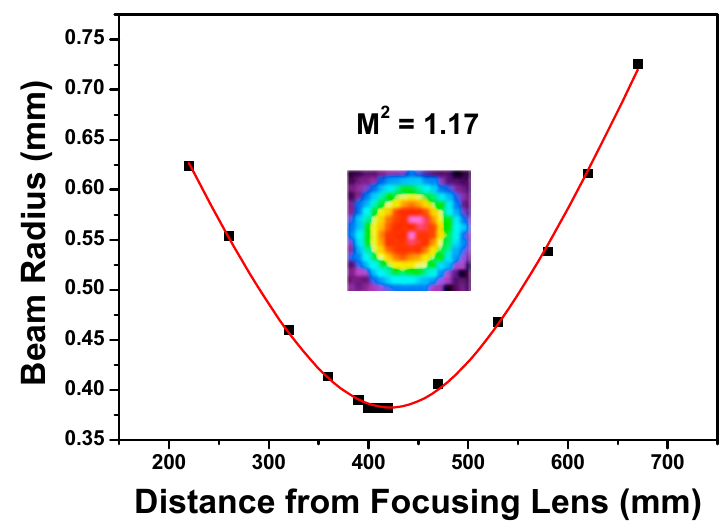
Figure 7. The beam radius of the SLM Ho:SSO laser. Inset: The typical 2D beam profile.